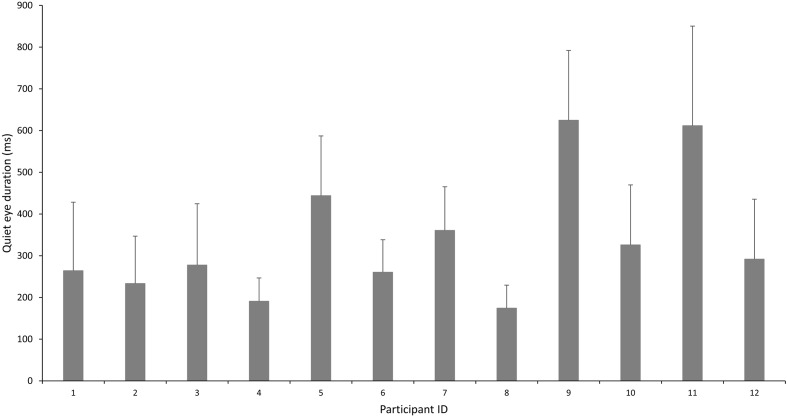
Inter-individual variation in quiet eye duration (ms) amongst the less skilled participants.